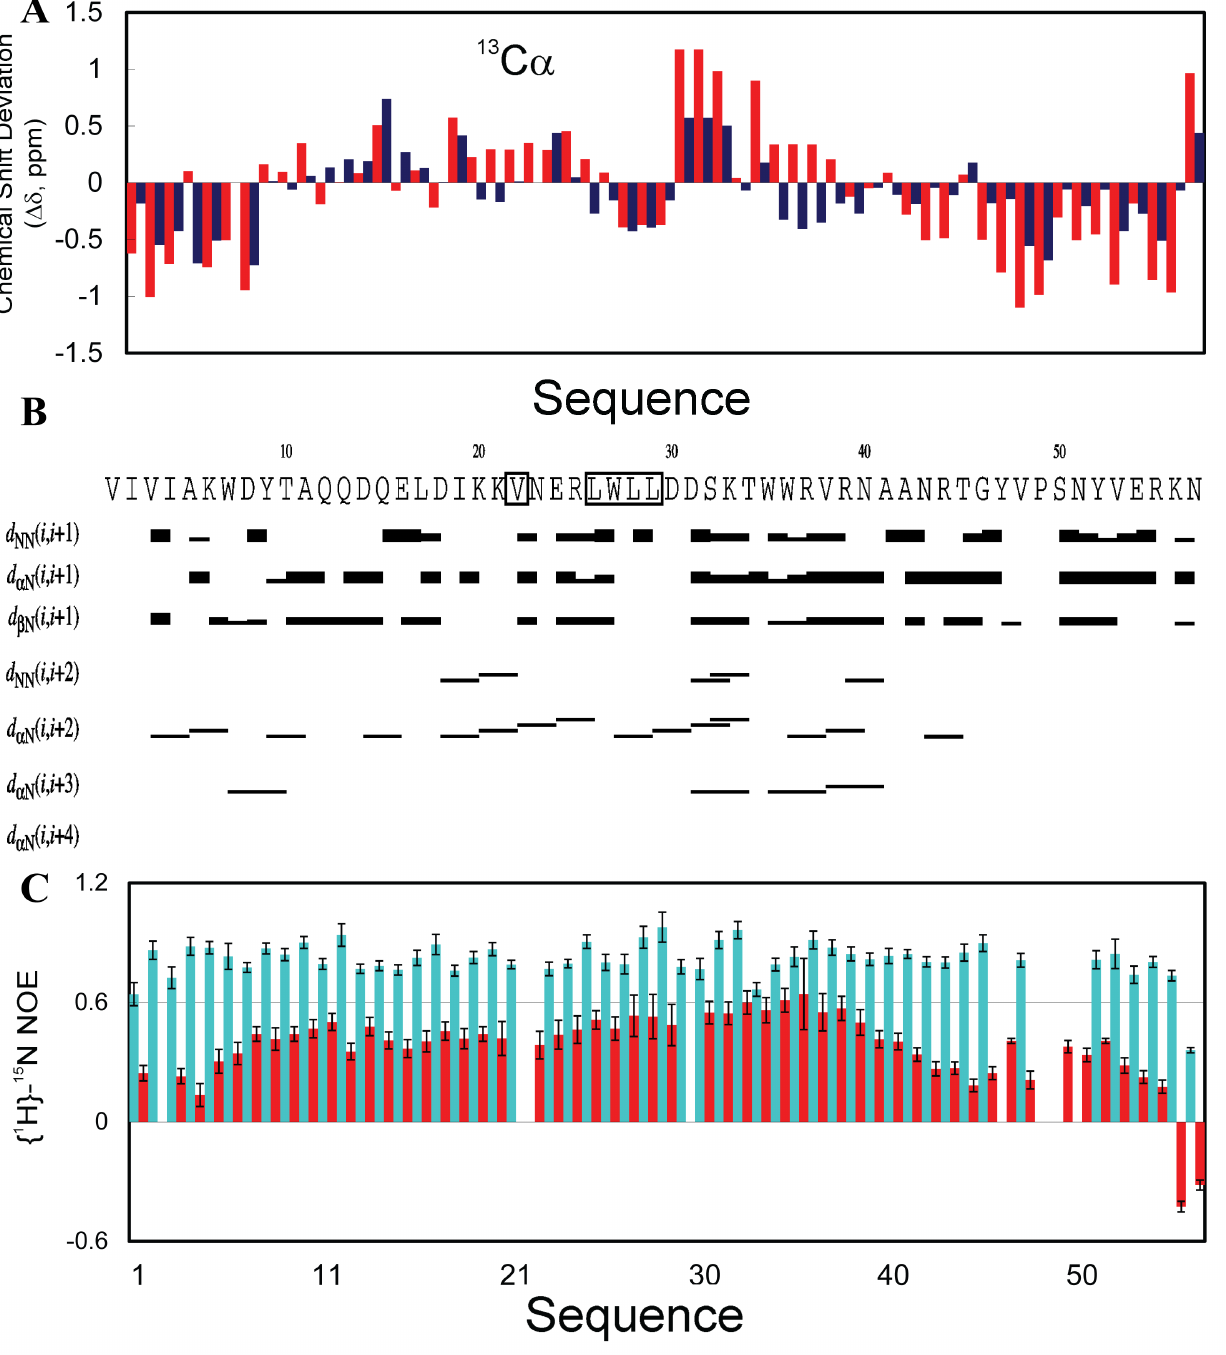
Figure 9. Residue-specific conformations of V22-SH3 in unsalted water. ( A ) Bar plot of C α chemical-shift deviations from their random- coil values for V22-SH3 (red), and wild-type in the presence of 8 M urea (blue). ( B ) Characteristic NOEs defining secondary